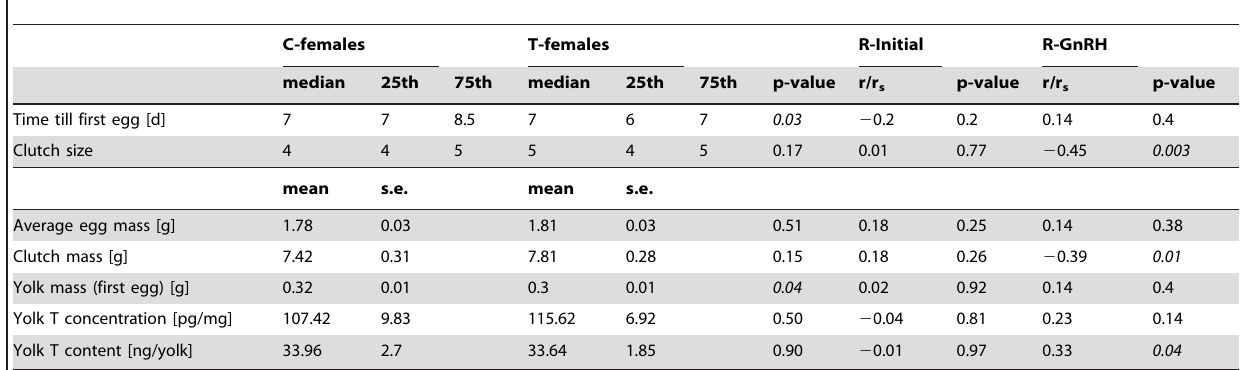
Table 1. Female reproduction in relation to yolk testosterone, plasma testosterone and testosterone response to